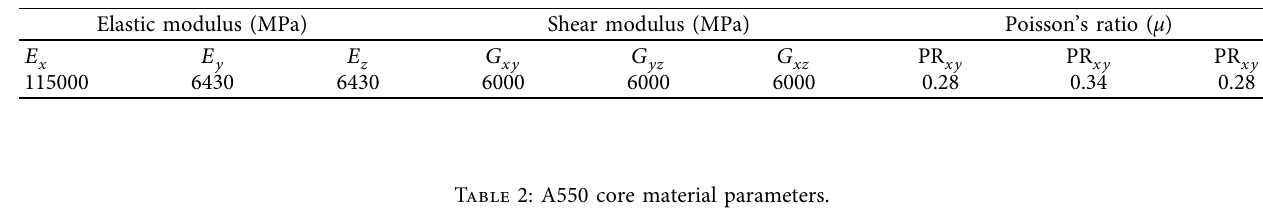
Table 1: T700 material parameters.